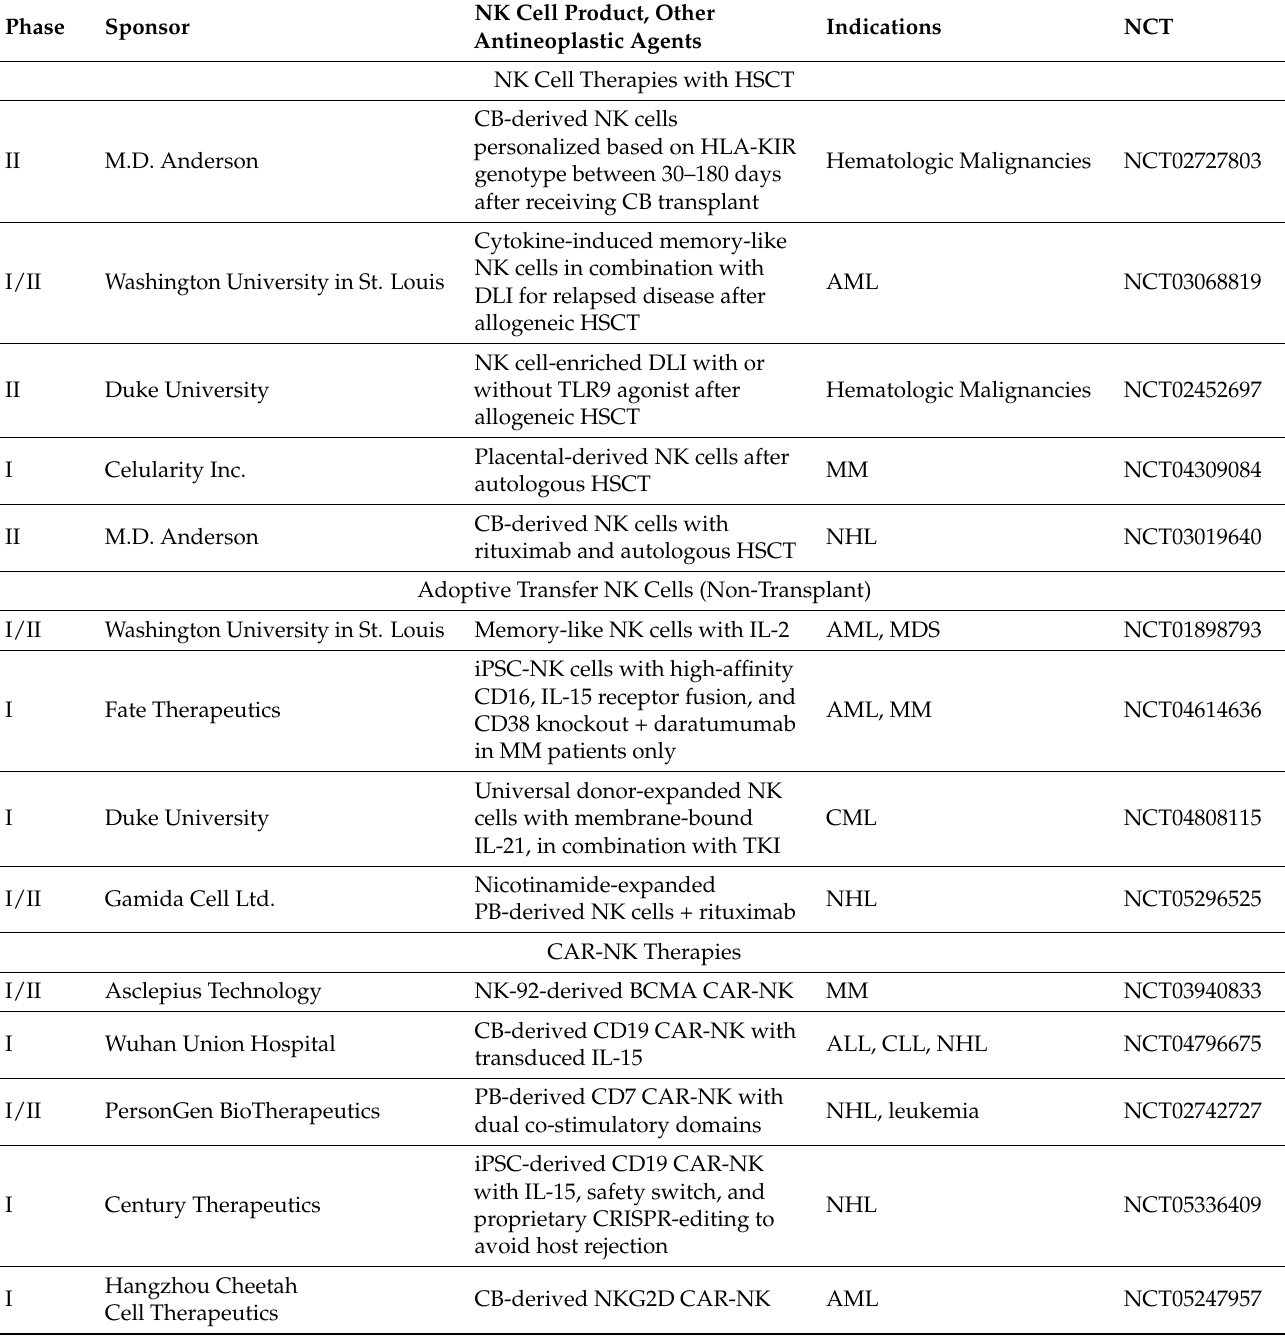
Table 1. Summary of select ongoing clinical trials evaluating allogeneic NK cellular therapies in hematologic malignancies. NCT: National Clinical Trial number (clinicaltrials.gov), NK: natural killer, AML: acute myeloid leukemia, MDS: myelodysplastic syndrome, MM: multiple myeloma, NHL: non-Hodgkin lymphoma, CLL: chronic lymphocytic leukemia, TLR-9: iPSC: induced pluripotent stem cells, TKI: tyrosine kinase inhibitor, CAR: chimeric antigen receptor, PB: peripheral blood, CB: cord blood, HSCT: hematopoietic stem cell transplantation, PD-1: programmed cell death protein-1, HLA: histocompatibility antigen, KIR: killer Ig-like receptors, DLI: donor lymphocyte infusion,